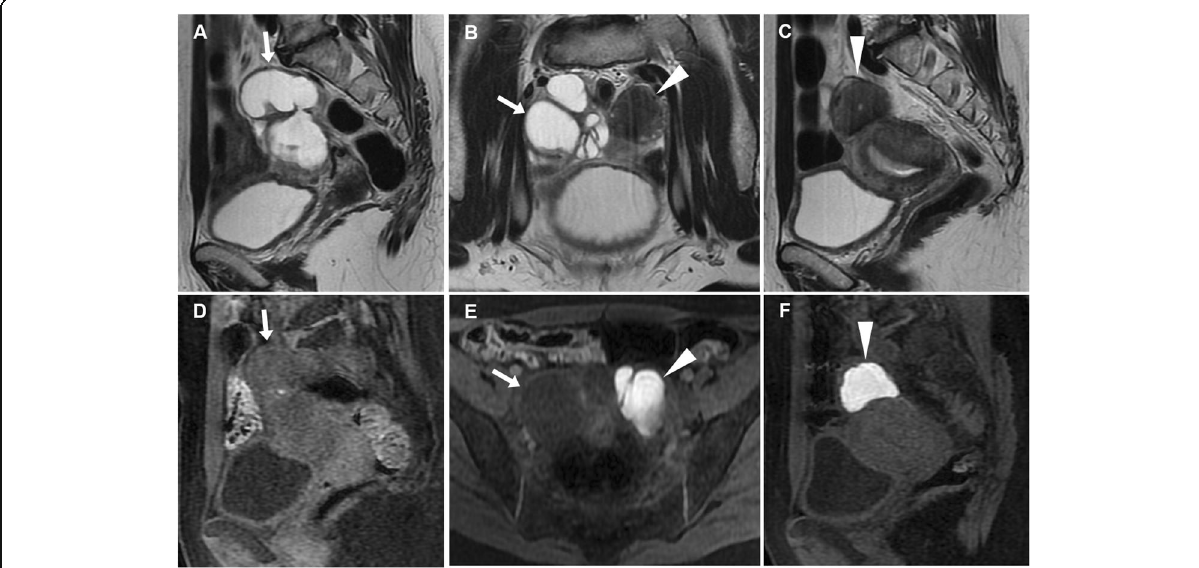
Fig. 16 Acute onset of endometriosis in a 37-year-old woman with acute pelvic pain and fever for the last 4 days. Sagittal ( a ), oblique-coronal ( b ) T2-weighted images and sagittal ( d ), oblique-coronal ( e ) fat-suppressed T1-weighted images show a distended serpiginous right fallopian tube (arrows) with homogeneously high T2-weighted signal and low T1-signal intensity, consistent with hydrosalpinx. Additionally, oblique-coronal ( b ) and sagittal ( c ) T2-weighted images, oblique-coronal ( e ) and sagittal ( f ) fat-suppressed T1-weighted images demonstrate an endometriotic cyst of the left ovary (arrowheads) showing high T1 and low T2 signal (shading